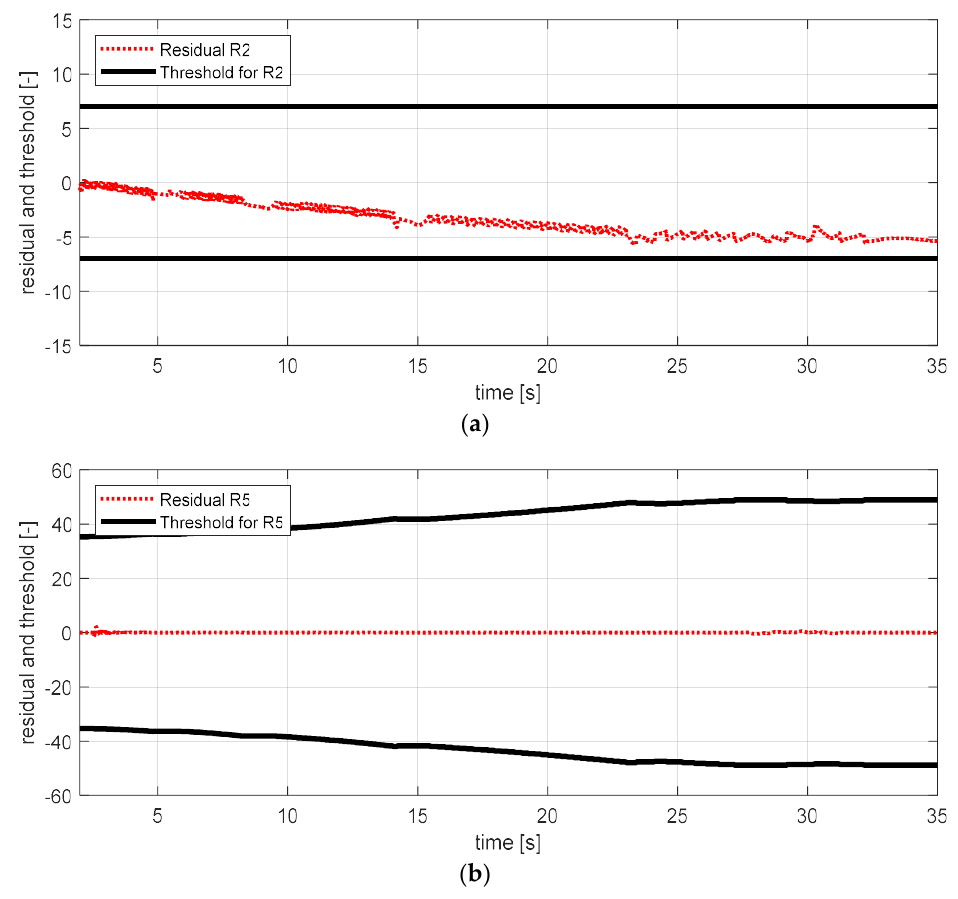
Figure 23. FDI simulation result for wheel angular speed sensor—fr (normal). ( a ) Residual 2 and threshold; ( b ) residual 5 and threshold.